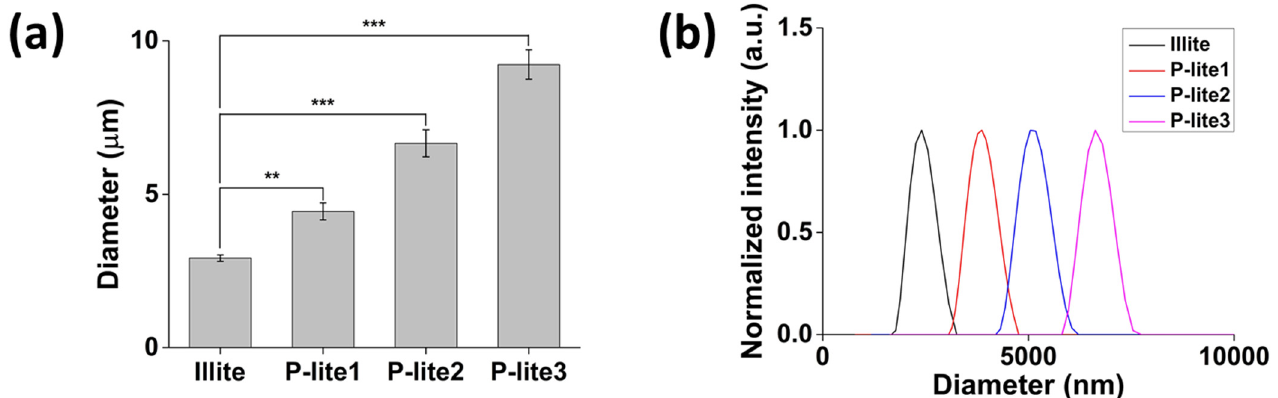
Figure 2. Characterization of illite and P-lite MPs. ( a ) Hydrodynamic diameters and ( b ) size distribution graphs of illite and P-lite MPs prepared using different weight ratios of PVP to illite. PVP, polyvinylpyrrolidone; P-lite MP, PVP-stabilized illite microparticles; P-lite1, 1:5 weight ratio of illite:PVP; P-lite2, 1:10 weight ratio of illite:PVP; P-lite3, 1:20 weight ratio of illite:PVP; a.u., arbitrary units; ** p < 0.01; *** p < 0.001.